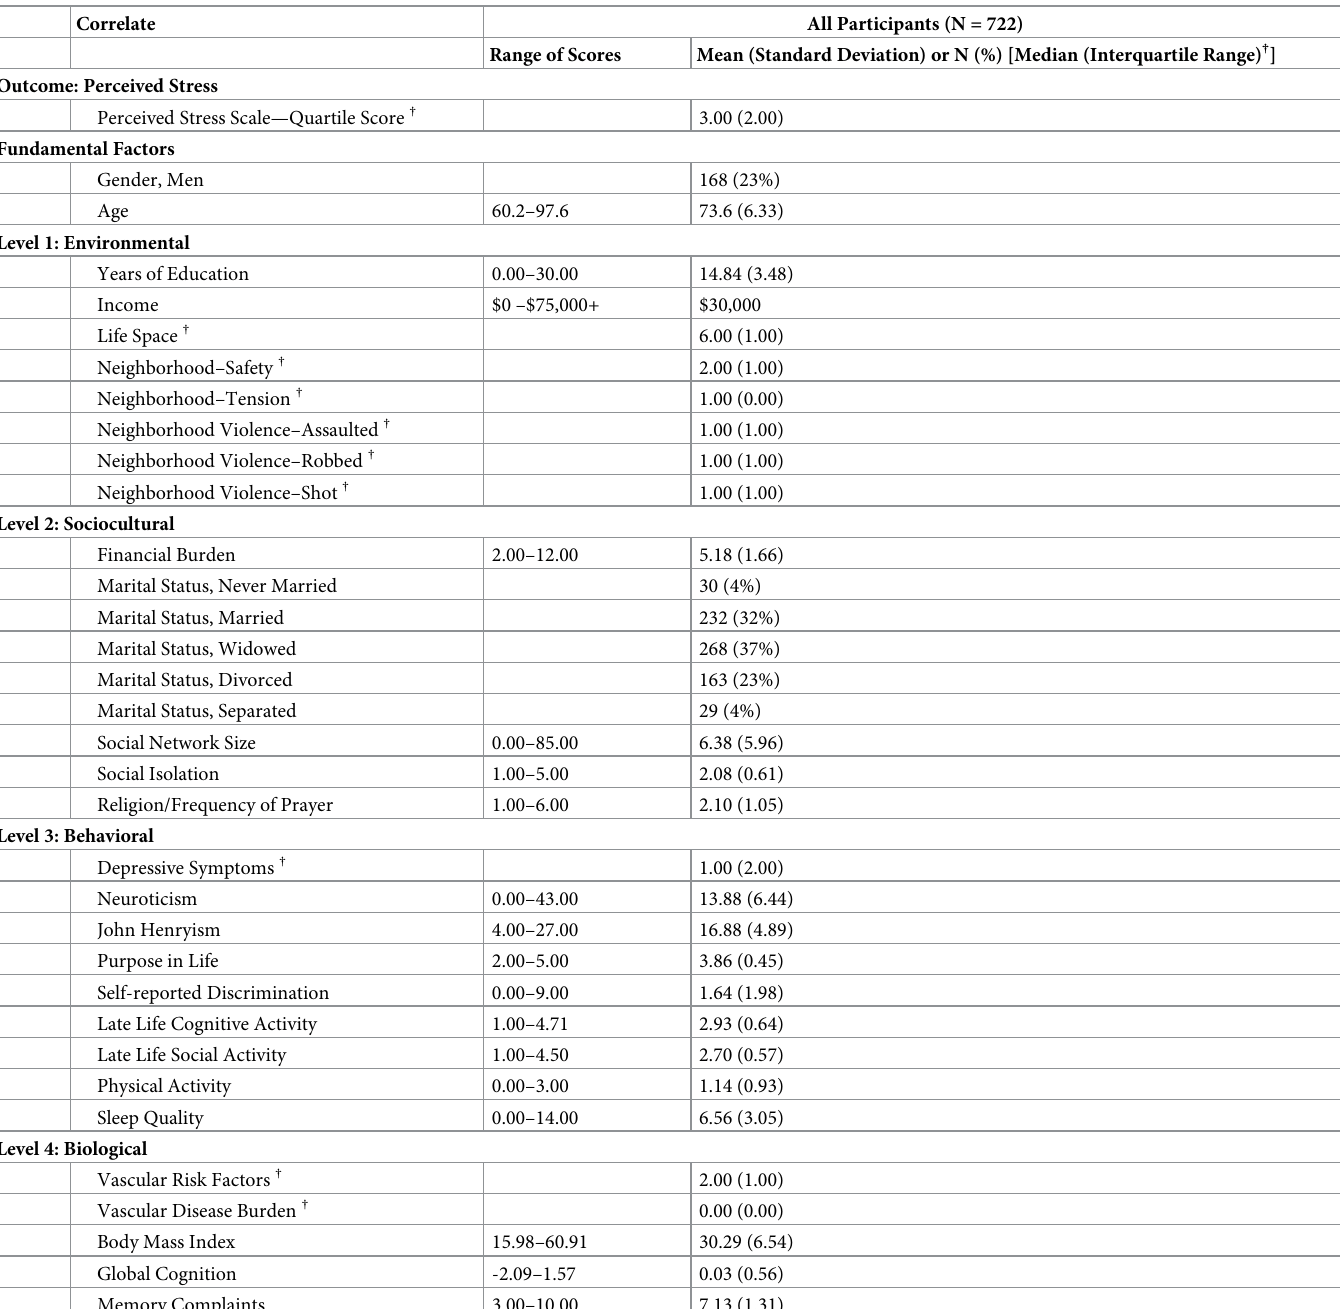
Table 2. Participant characteristics for all correlates by level.